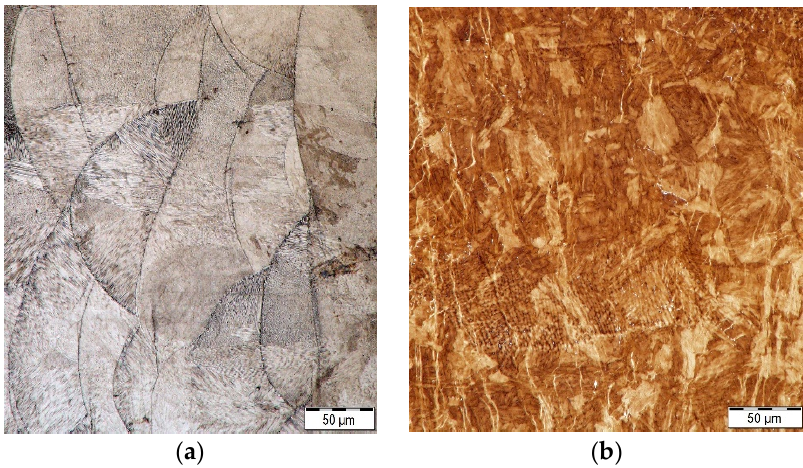
Figure 7. Light optical microscopy (LOM) images of ( a ) sample 1, ( b ) sample 5.